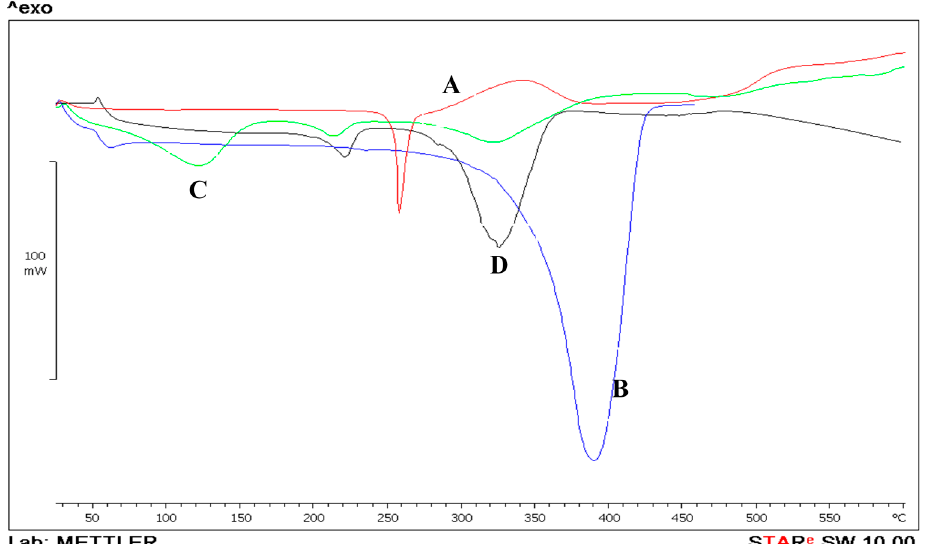
Figure 6. Differential scanning calorimetry thermograms of prednisolone ( A ), PLGA ( B ) and prednisolone-PLGA nanoparticles ( C ), PVA ( D ).